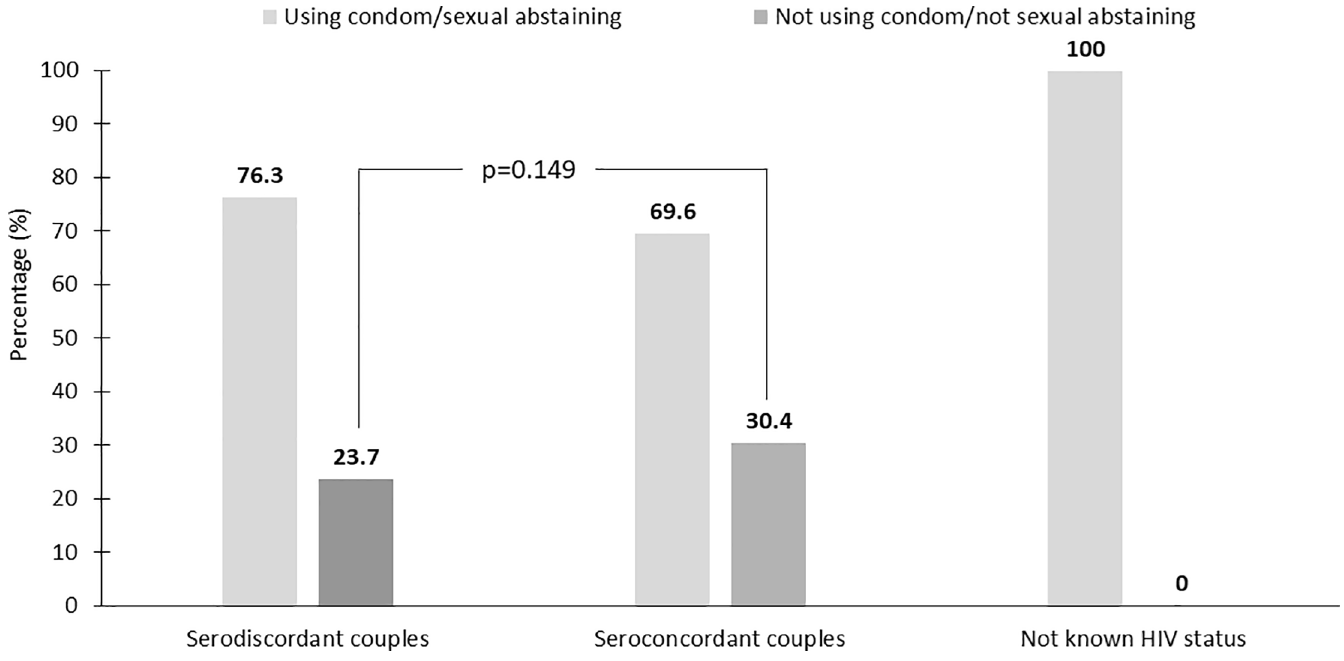
Fig 2. Proportion of couples using condoms or abstaining from sex, stratified by the HIV serostatus of the partners.